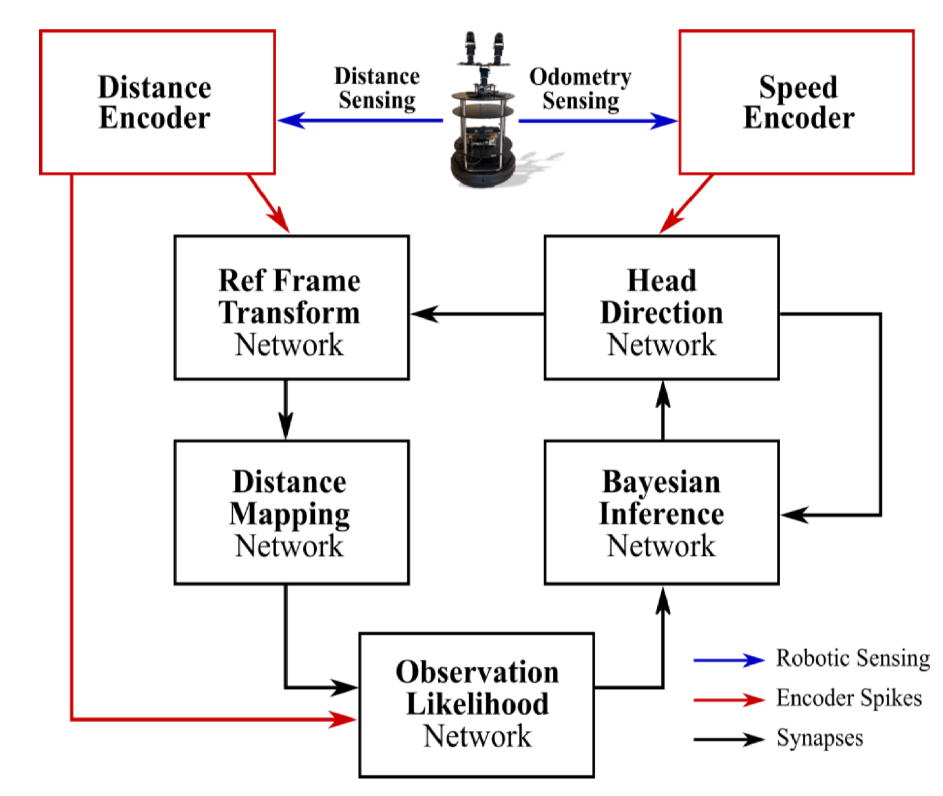
Figure 6. The overall structure of SNN architecture for SLAM. Courtesy of [88]. Table 3 summarizes the use of SNNs in the field of